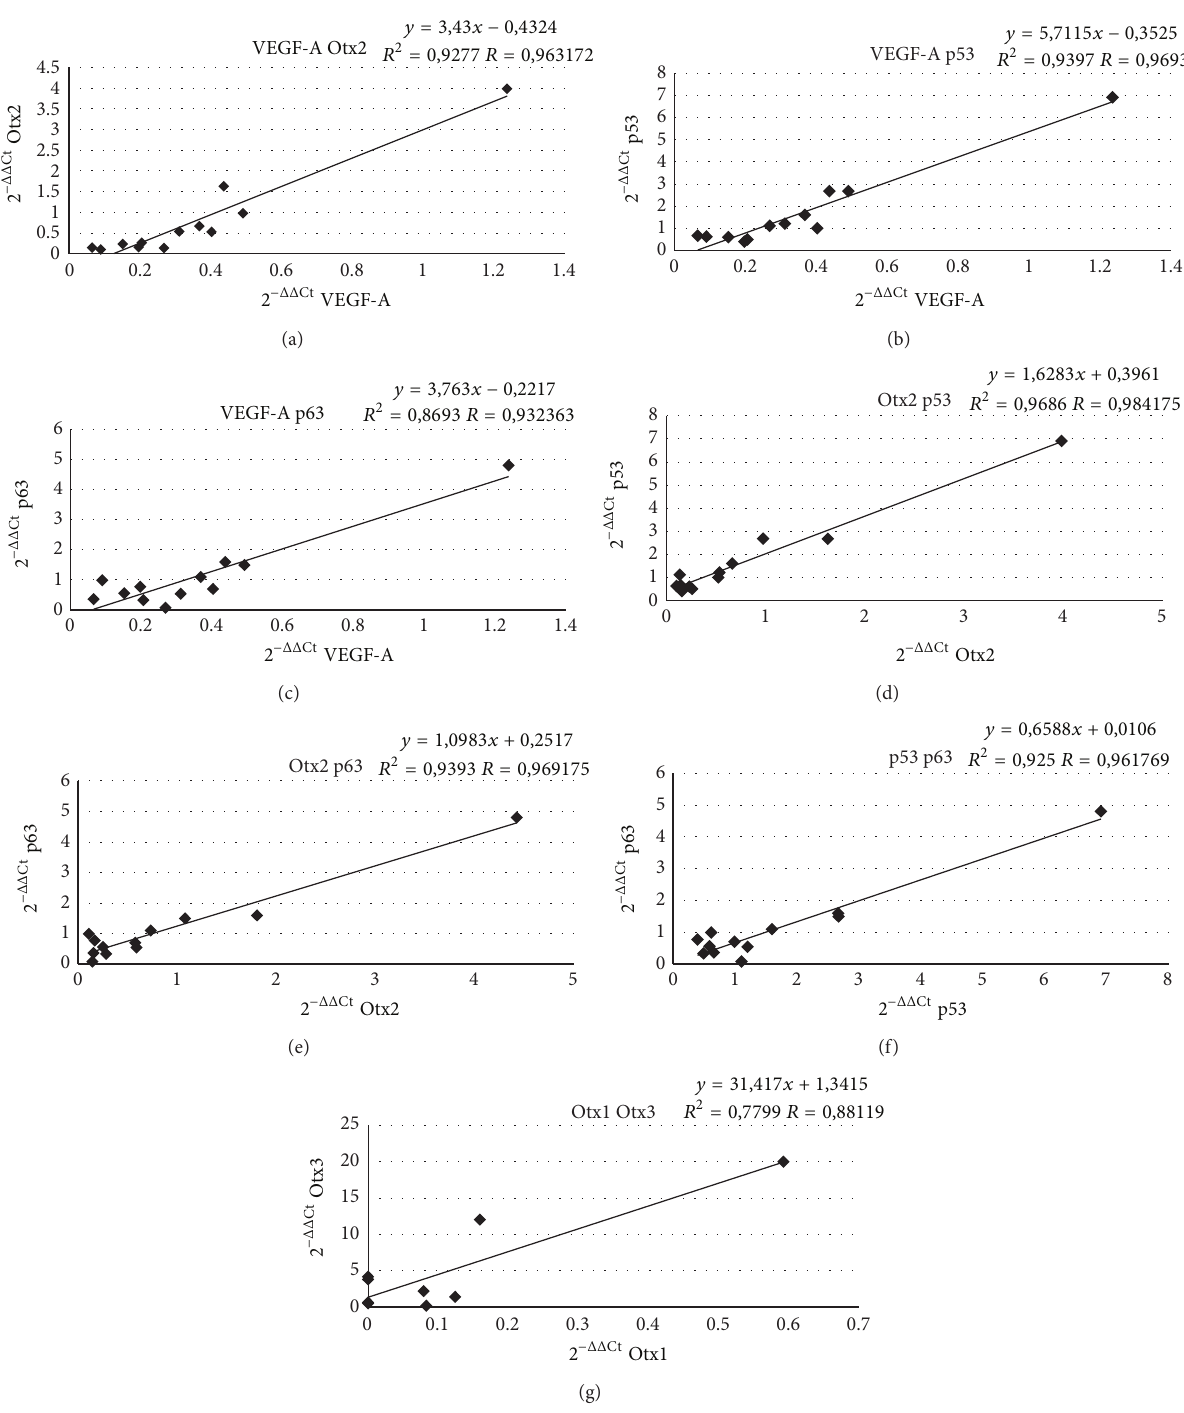
Figure 4: Statistical correlation among VEGF-A, Otx2, p53, and p63 genes and between Otx1 and Otx3 genes. Dispersion plots correlate two genes for graphic. 𝑥 - and 𝑦 -axes indicate 2 −ΔΔ Ct values that represent gene expression levels. Linear regression coefficient (𝑅) > 0.80 indicates a statistically significant